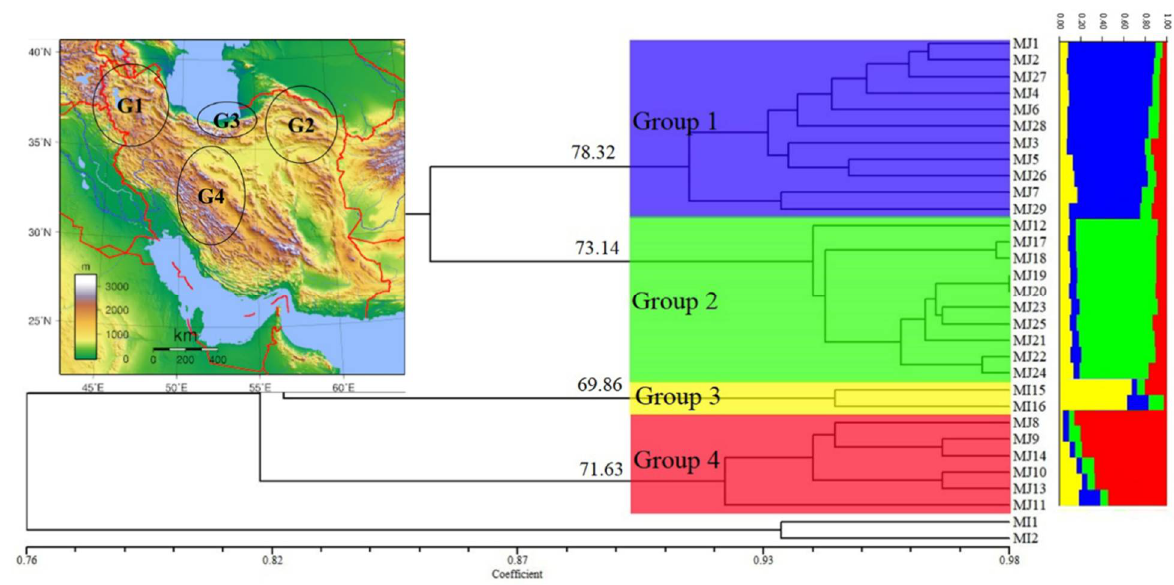
Figure 4. UPGMA cluster diagram based on Dice coefficient estimated from 339 RAPD and ISSR markers for 29 populations of the Meloidogyne javanica (for population codes, see Table 1 and for geographic distribution, see Figure 1). The values on the dendrogram give the stability of main clades as estimated with a bootstrap procedure. Bar graphs showing genetic diversity structure, as assessed using the Structure software. Each group is represented by a different color (blue, green, yellow, and red). The geographic distribution of the groups is presented in the Iran map in the above-left corner.